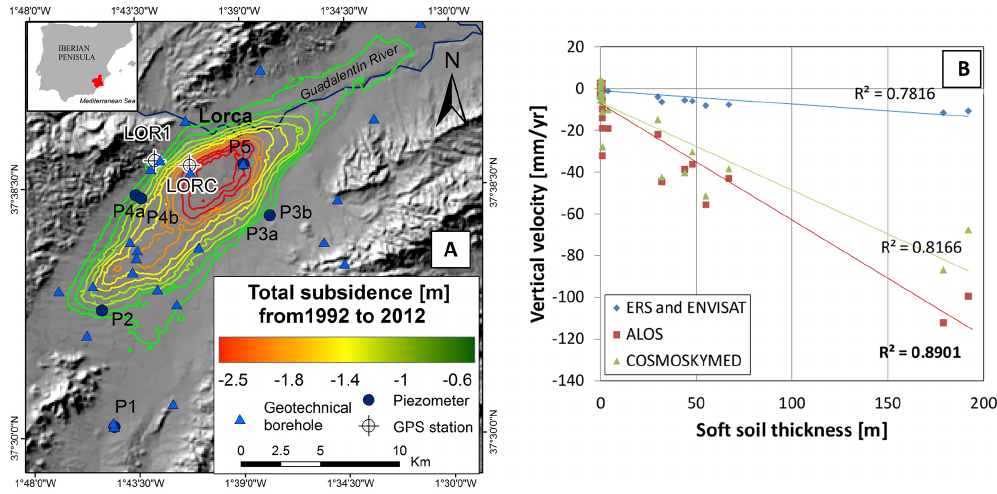
Figure 1. (a) Cumulated displacements (m) of the Alto Guadalentín Basin from 1992 to 2012. (b) Soft soil thickness calculated for each geotechnical boreholes and vertical velocity detected by the different sensors in the proximity of the boreholes. R 2 stand for Pearson corre- lation